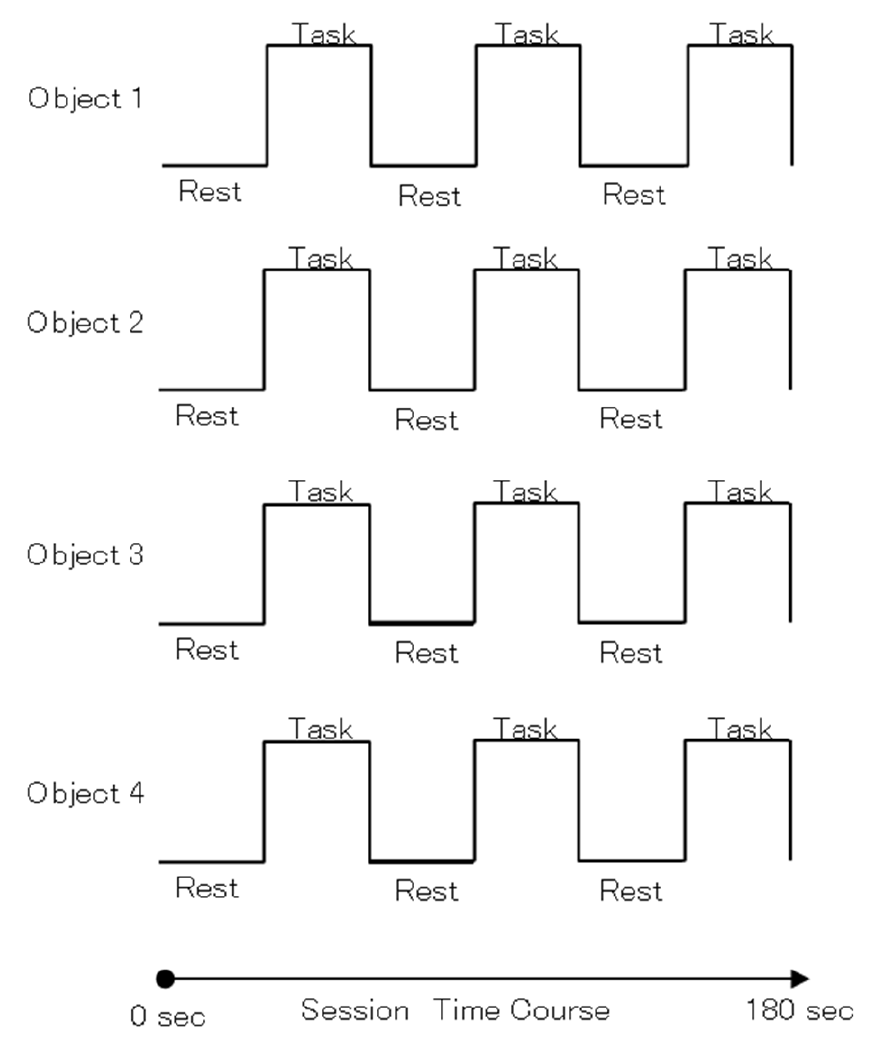
Figure 2. Block design of the stimulus task: 30 s, 30 s per task, three intervals per object.